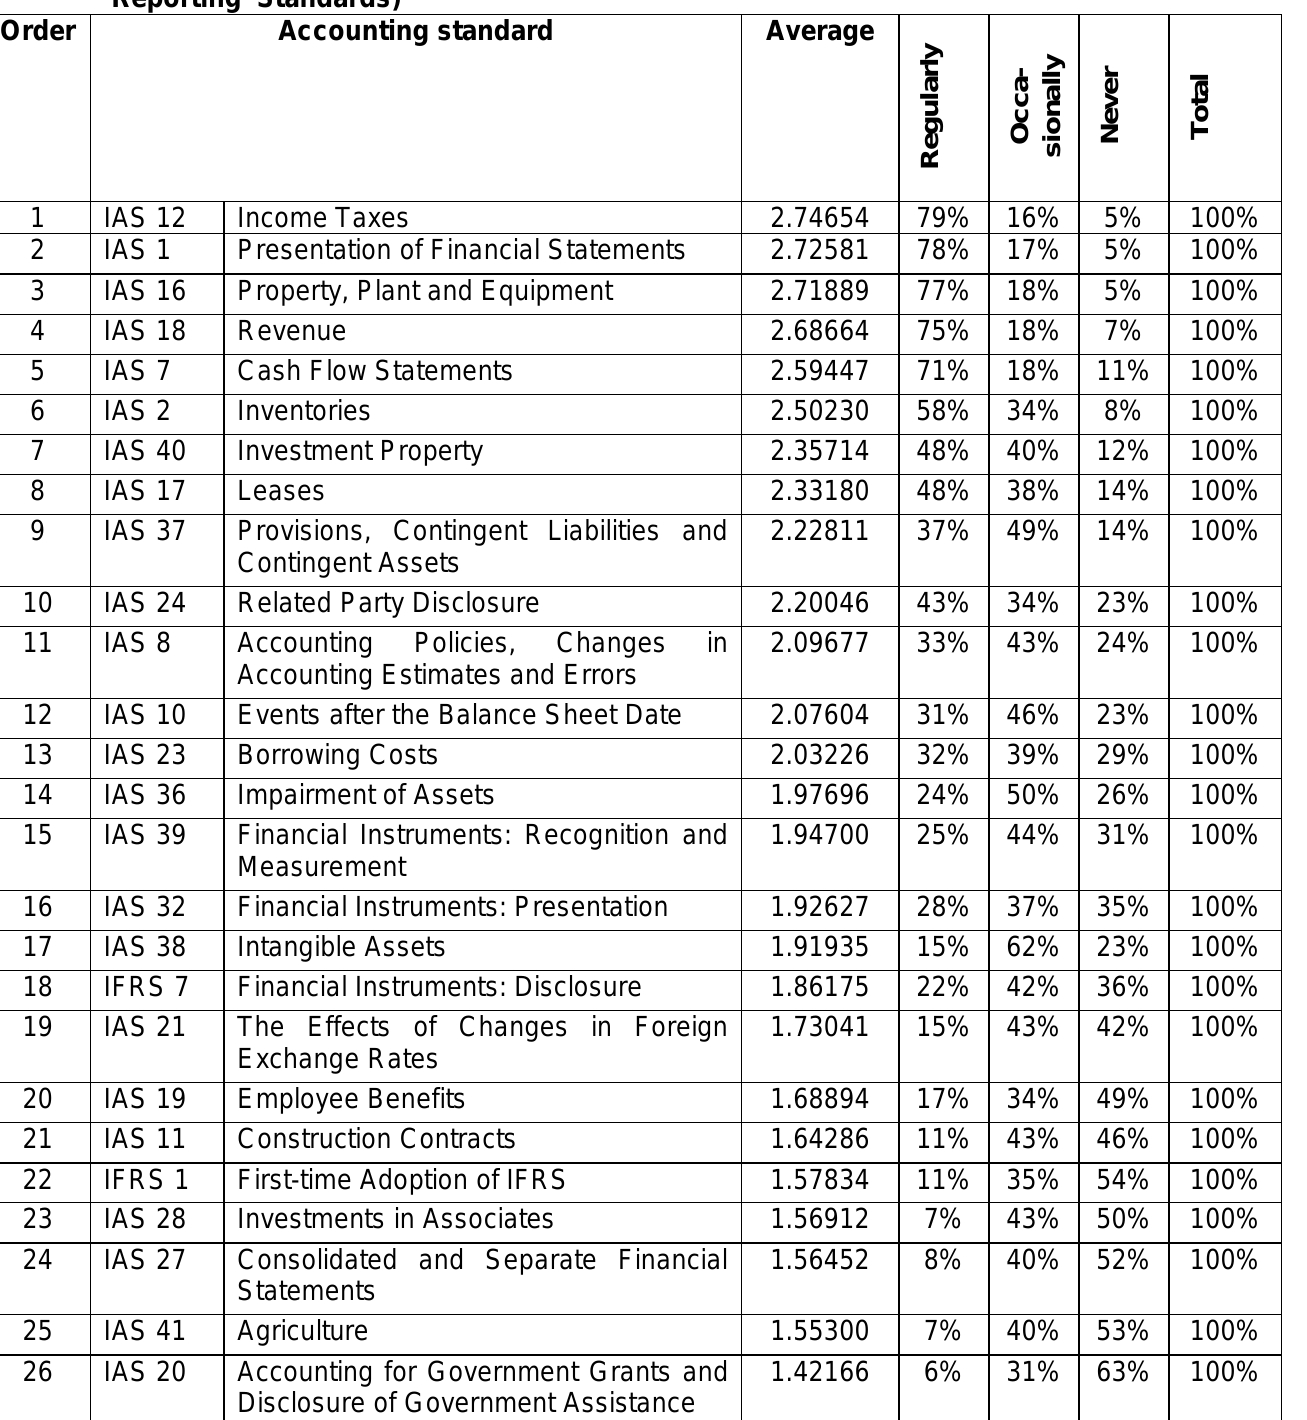
Table 1: Application of accounting standards (IFRSs - International Financial Reporting